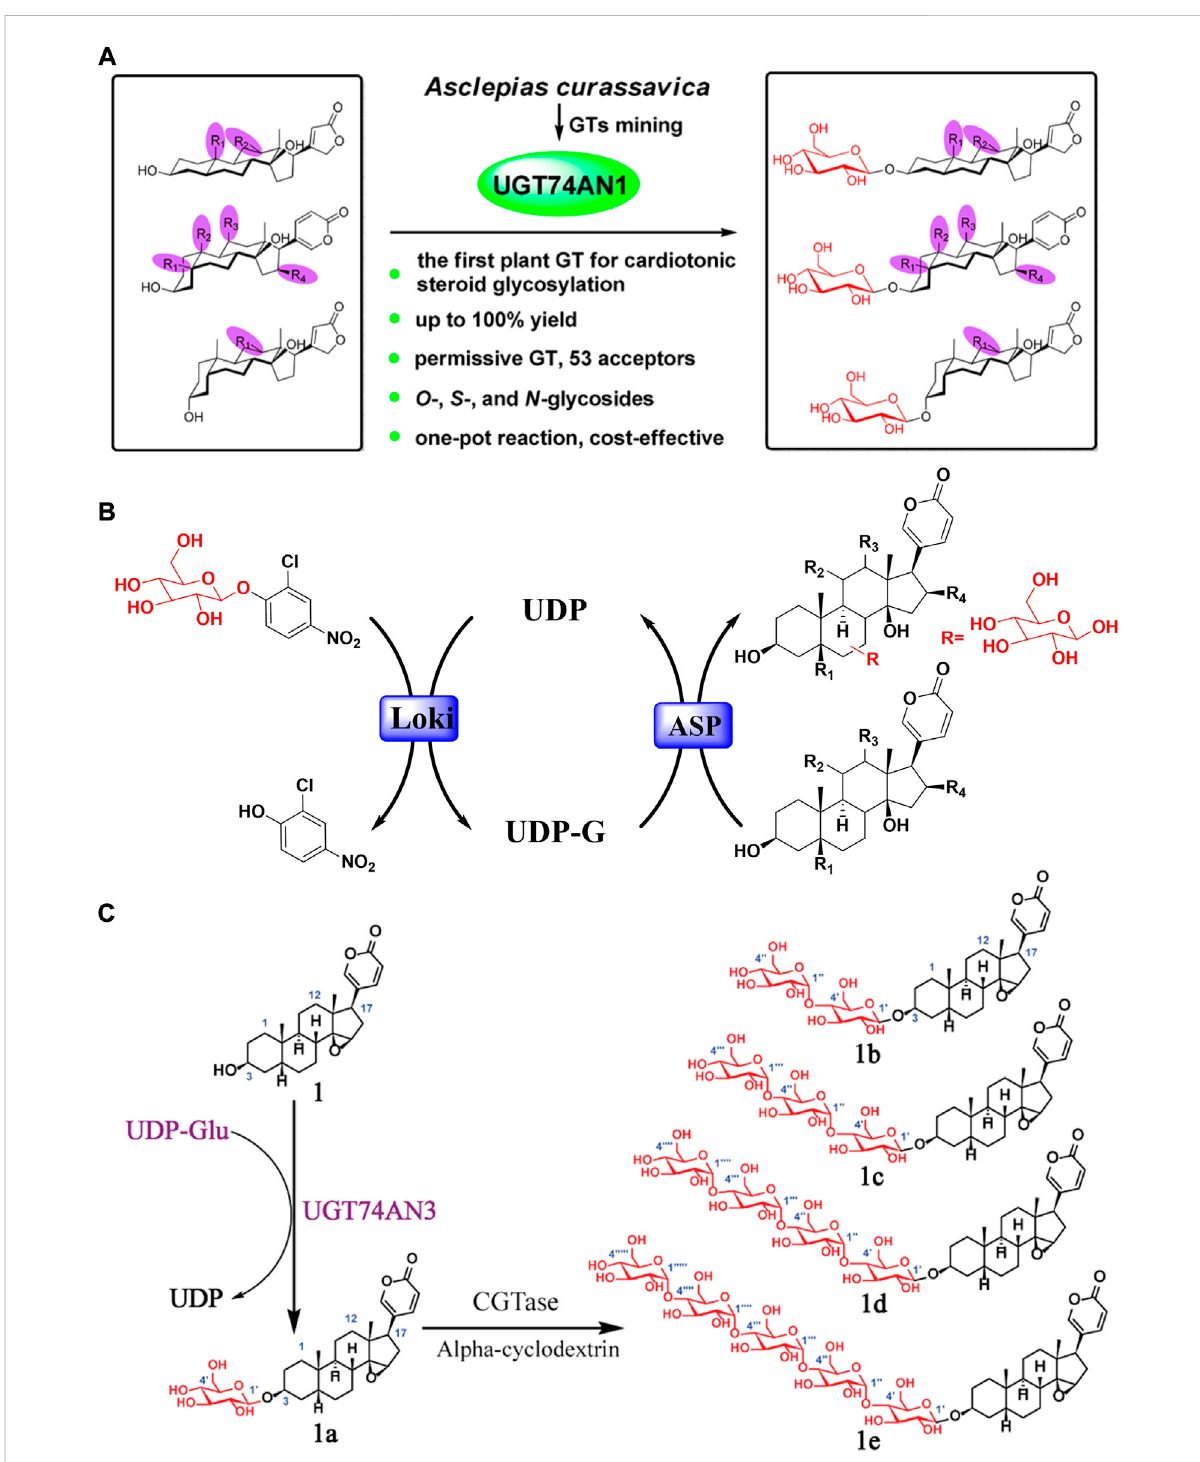
FIGURE 6 Glycosylation structure modi fi cation of bufadienolide: (A) UGT74AN1 catalyzed glycosylation of bufadienolide with regiospeci fi city; (B) The typical one-pot glycosylation system for bufadienolide; (C) Bufadienolide derivatives linked with sugar chains of varied length at the C-3 position obtained by enzyme catalyzed